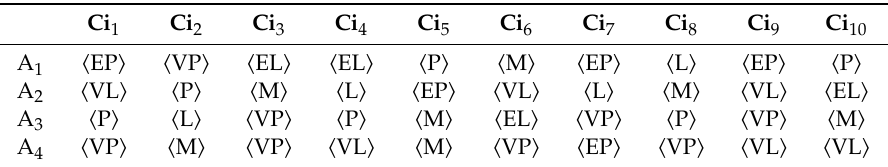
Table 17. Judgments matrix for alternatives.